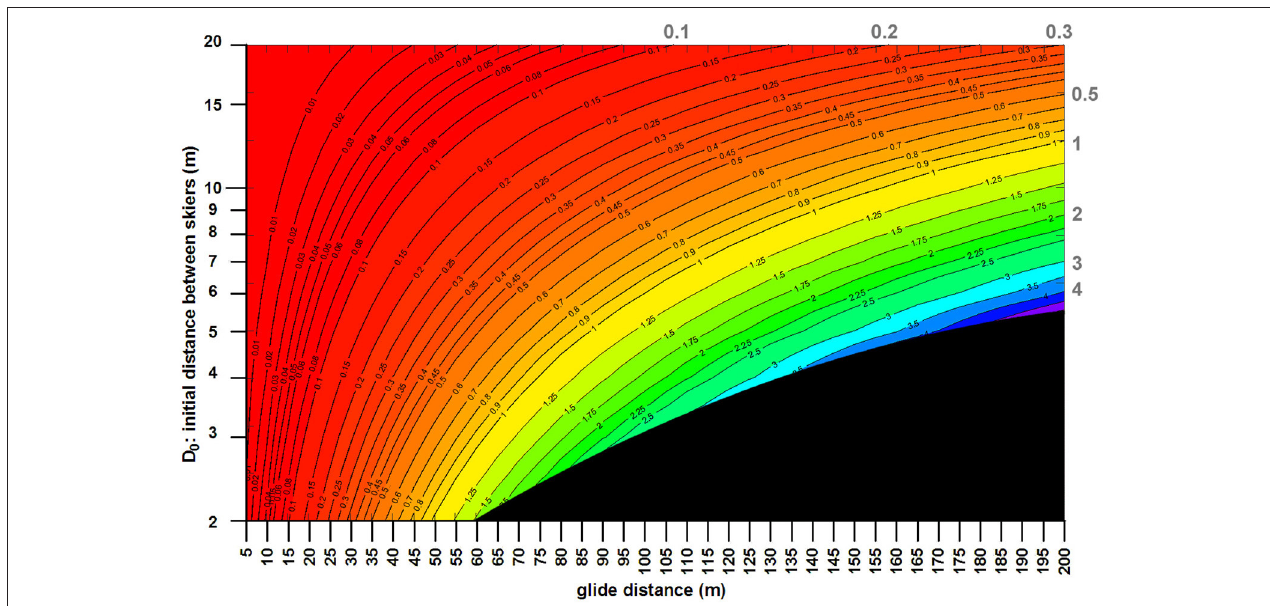
FIGURE 2 | Initial distance ( D 0 ) between the two skiers against the glide distance; the contour lines (and the gray values at the top and right side of the plot) correspond to the ground made up (in meters) across the glide distance. The black triangle at the bottom right corner corresponds to unfeasible ground made up, i.e., the minimum distance between the skiers at the end of the glide distance is confined to 0.5m. In this contour plot, the conditions for both skiers were as follows: mass (body plus gear) 90kg, kinetic friction coefficient between ski and snow 0.05, initial speed at the beginning of the glide 70 kph; slope angle 20 ◦ ; air = = = = density 1.2 kg/m 3 (e.g., at 1,000m altitude, 12.3 ◦ C, and humidity < 60%). At these conditions, if the initial distance between the two skiers is 6m at the beginning = − of the glide, then the ground made up after a 145m glide is 2m (contour), with a final distance of 4m between the two